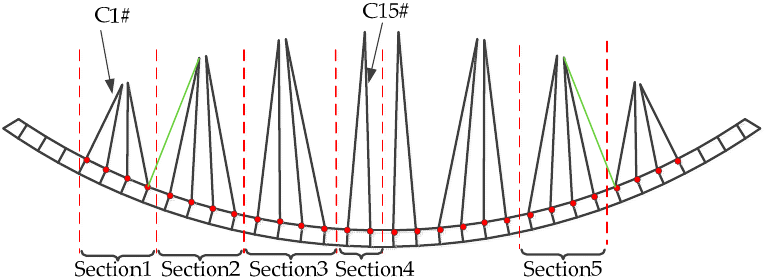
Figure 8. Diagram of the CBUSB cable region division. Table 1. Cable breakage cases.